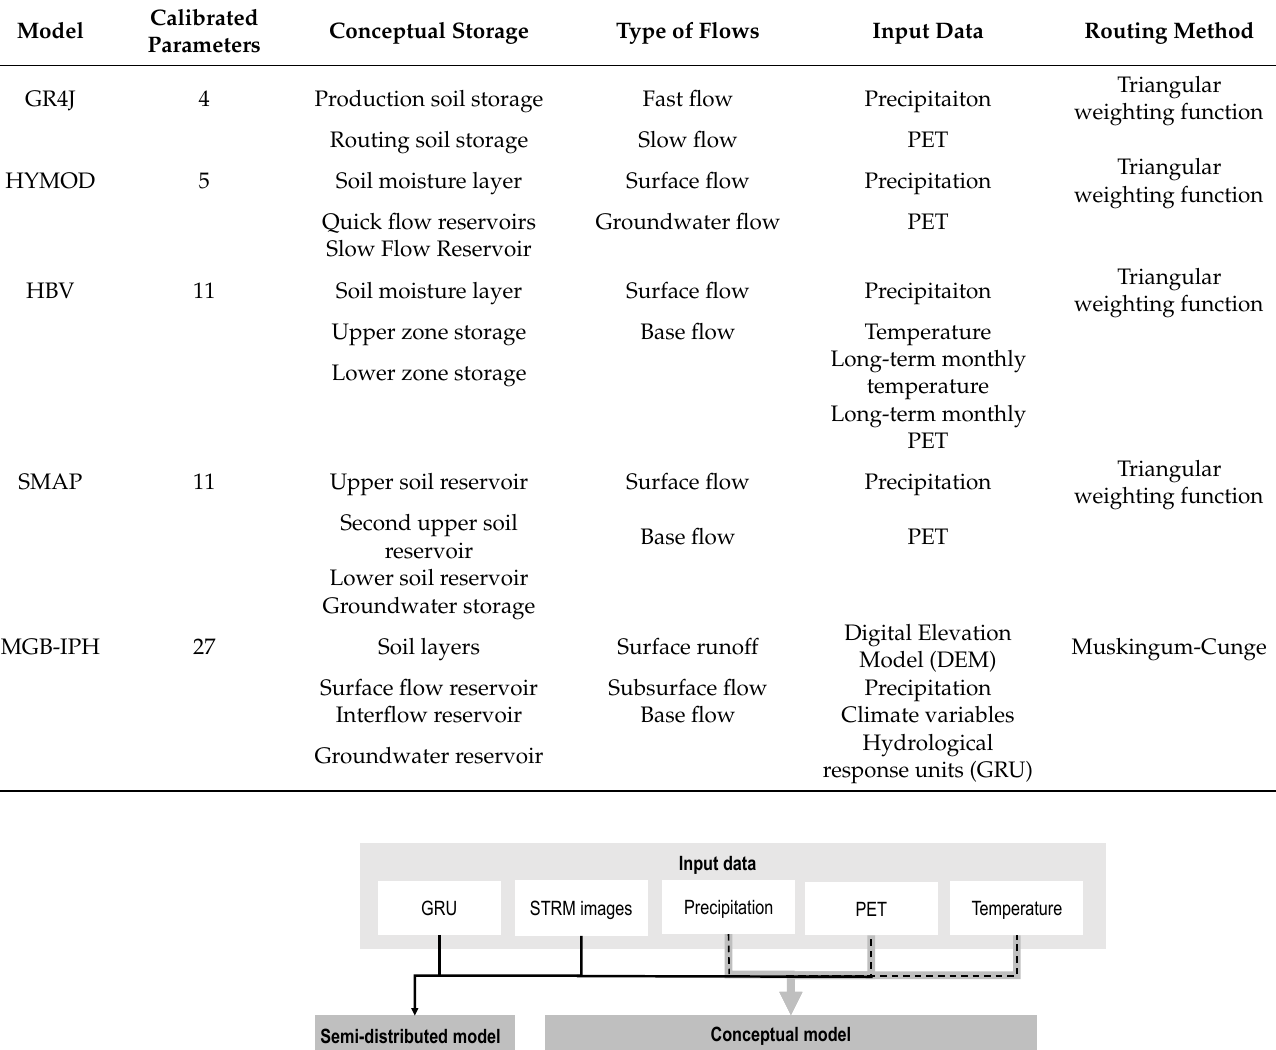
Table 1. Characteristics of the model structure of the hydrologic models used in this study.